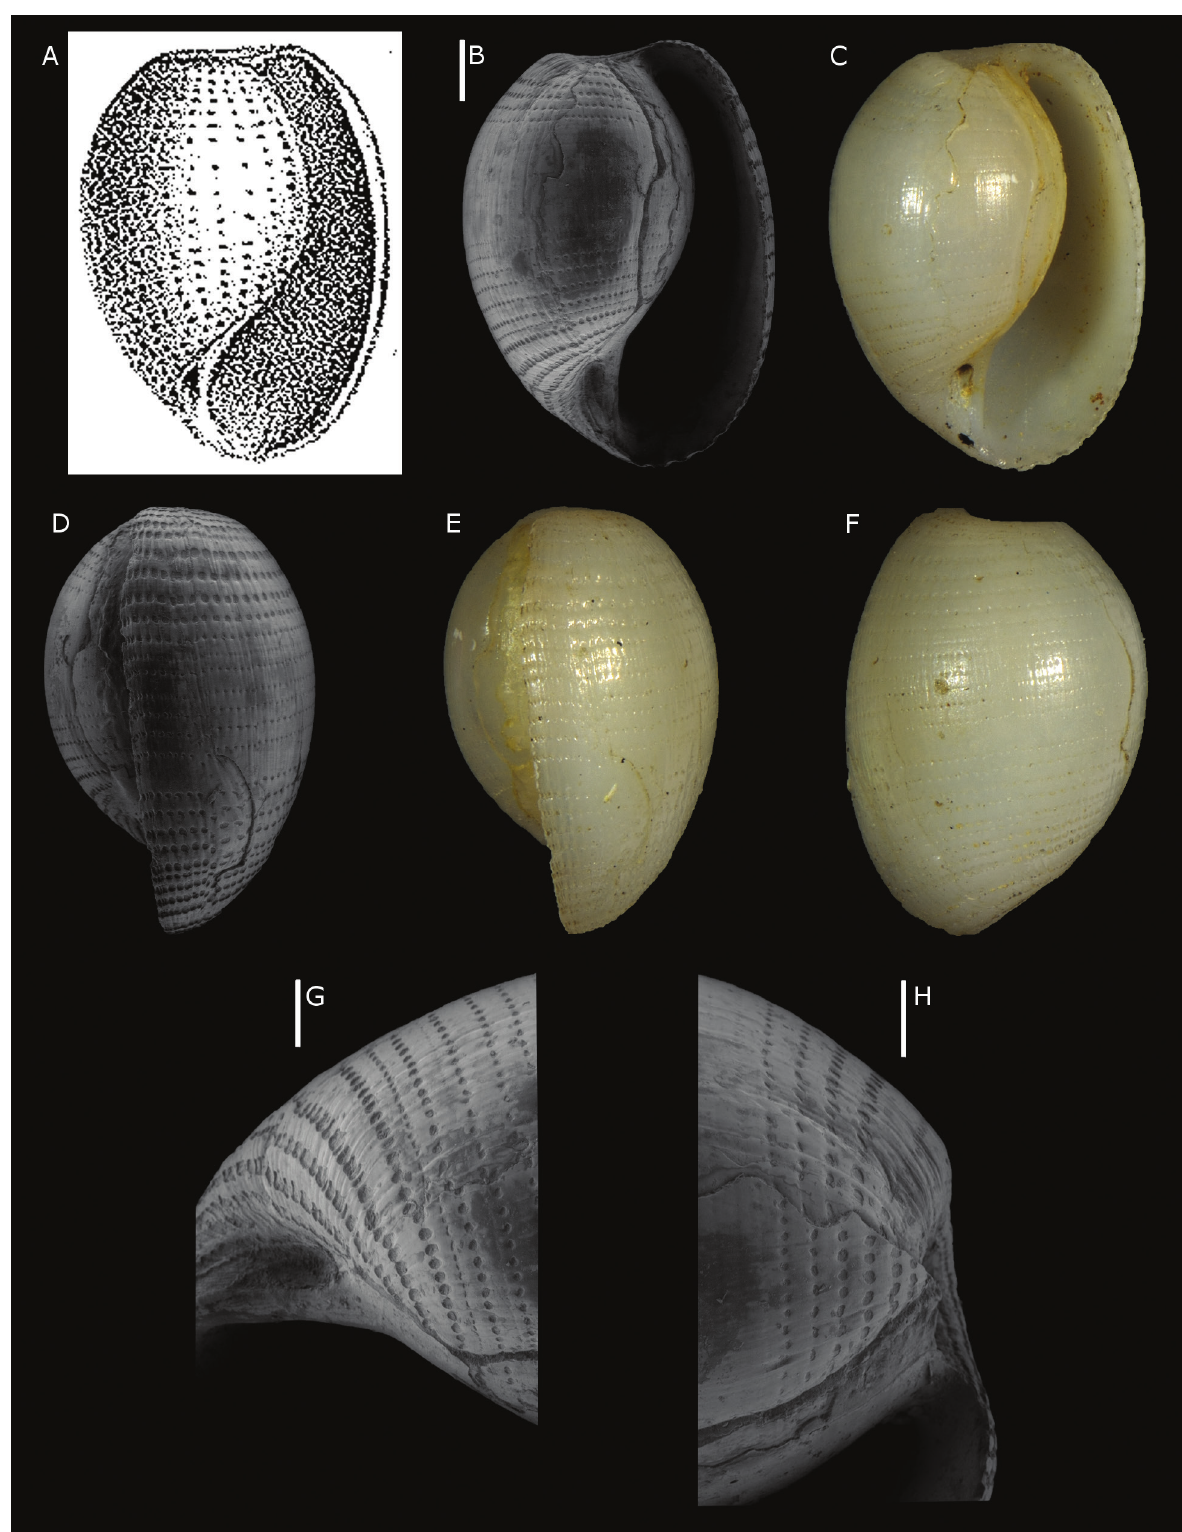
Figure 33. Atys lithensis Sturany, 1903, Station 144 (between Suakin, Sudan, Al Lith, Saudi Arabia, Red Sea). A . Original figure by Sturany (1903). B–H . Holotype, NHMW 84291: front ( B–C ), right side ( D–E ), back ( F ), microsculpture ( G–H ). Scale bars: B–F : 0.5 mm, G–H : 0.25